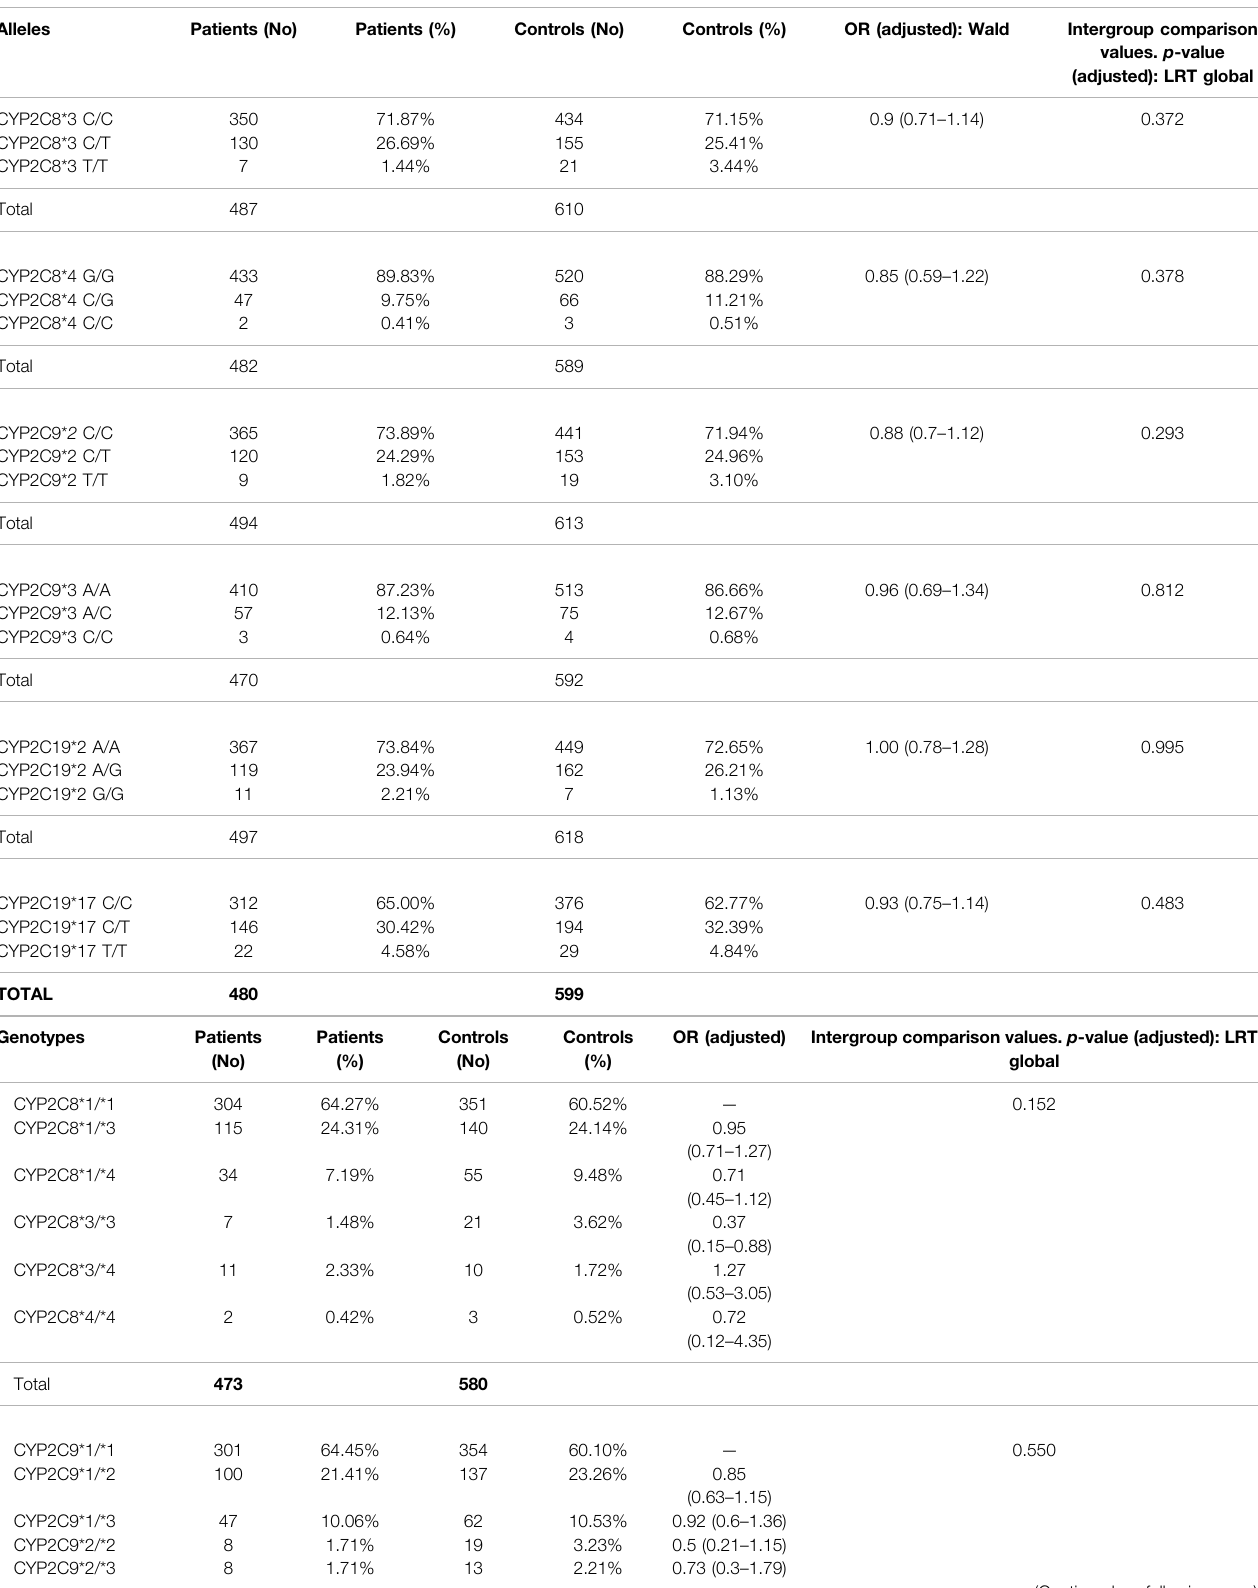
TABLE 4 | Alleles, genotypes and inferred phenotypes observed in overall patients and healthy controls.